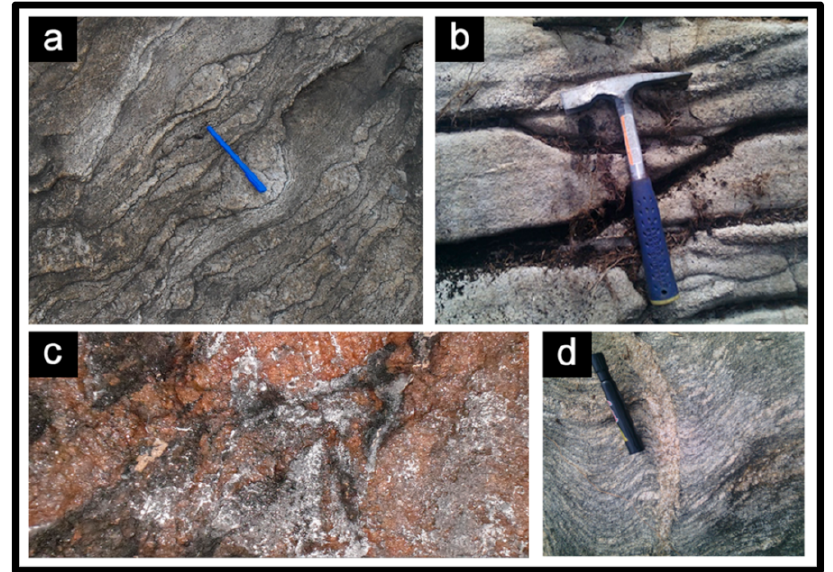
Figure 6. Some rock exposures in the study area (Oban Massif): ( a ) Migmatitic gneiss at Oban town displaying district foliation planes, ( b ) rock displaying various fracture patterns SW of Okitak farm, ( c ) rock displaying irregular-shaped pegmatite intrusions south of Okarara, not mappable to the scale of the map, and ( d ) banded gneiss mapped around Okarara